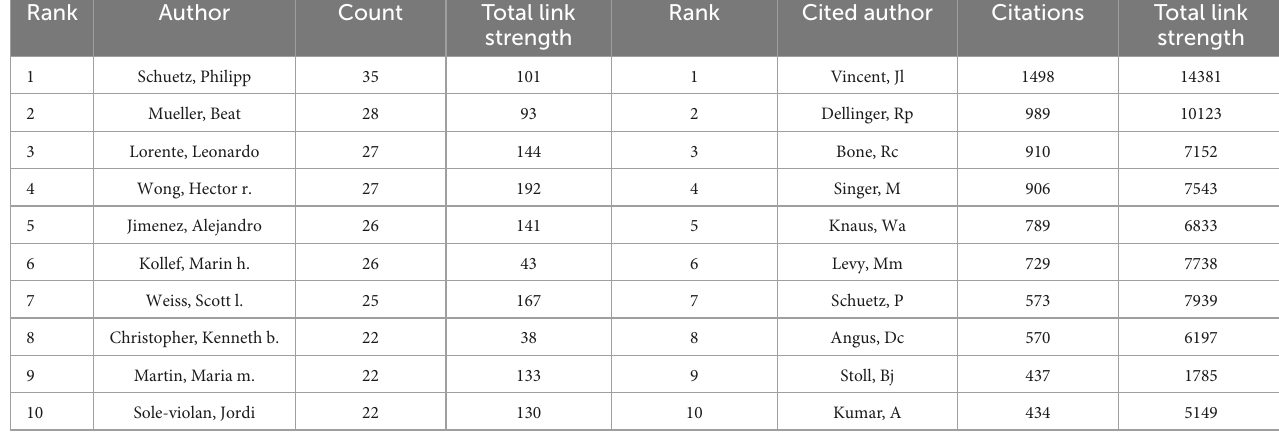
TABLE 2 The top 10 authors and cited authors with most publications on the application of artificial intelligence in sepsis from 2000 to